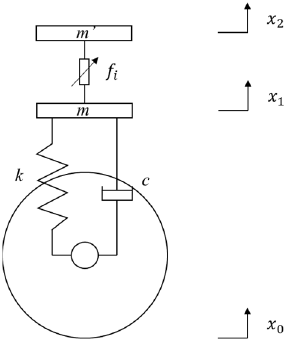
Figure 7. PID control model of semi-active suspension.